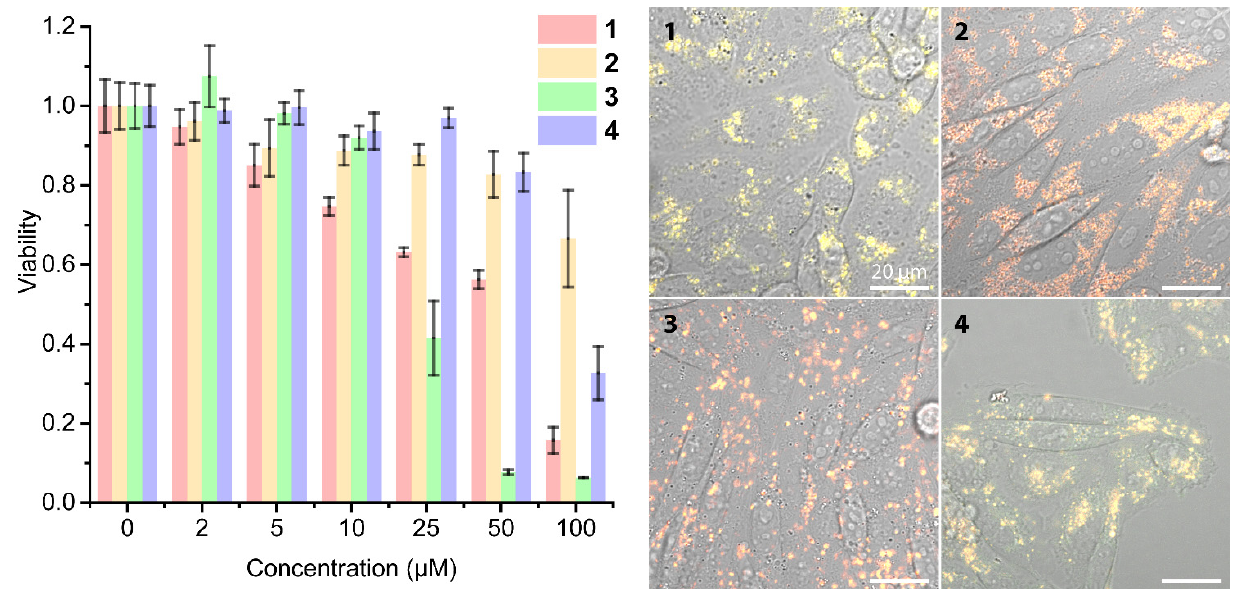
Figure 8. Left : MTT assay of CHO-K1 cells after incubation with complexes 1 – 4 for 24 h at different concentrations. Cell viability of control cells (without probe) was taken for 1. The data are shown as mean ± standard deviation. N = 6 repetitions for CHO-K1 cells. Right : Confocal microscopy of CHO-K1 cells incubated with complexes 1 – 3 (5 µM, 24 h) and 4 (25 µM, 24 h). Green, red, and DIC (differential interference contrast) channels are merged. Scale bar 20 µm.